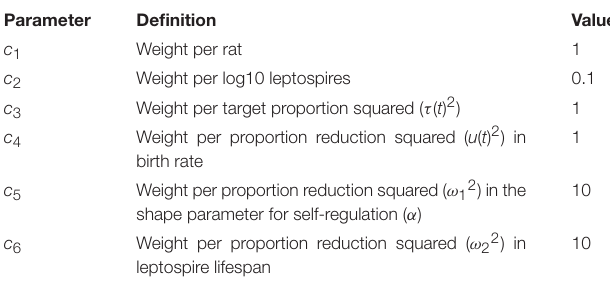
TABLE 2 | Value of fixed weights of rats, leptospires and the control